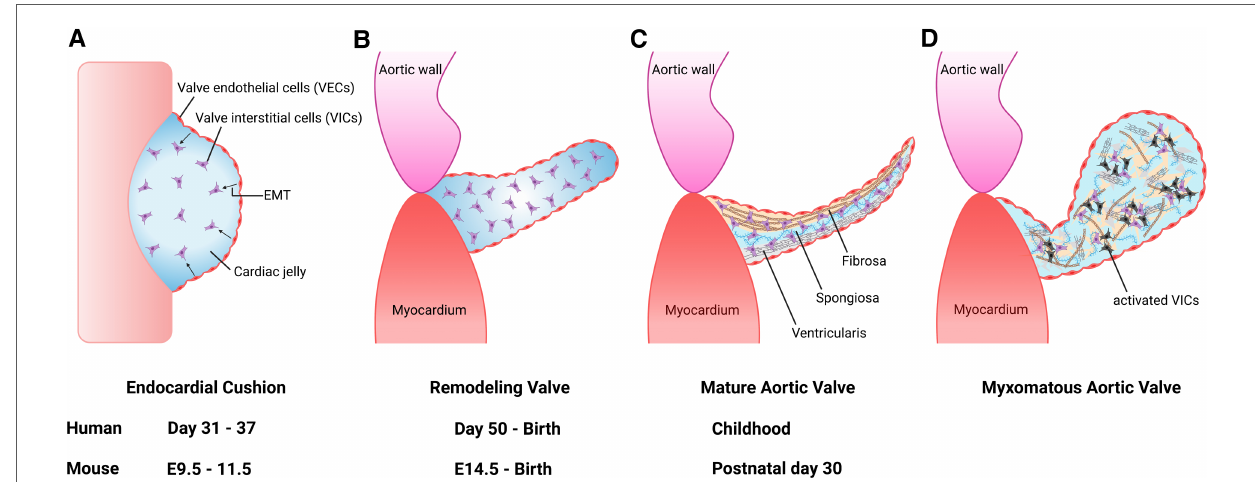
FIGURE 1 Aortic valve development and progression to myxomatous aortic valve. ( A ) Valve development begins with endocardial cushion formation. Valve endothelial cells (VECs) lining the cushion undergo endothelial-to-mesenchymal transformation (EMT) to differentiate into valve interstitial cells (VICs) between 7 and 9 weeks gestation in humans, and embryonic day ( E ) 9.5 and E11.5 in the mouse. ( B ) The out fl ow tract endocardial cushions undergo remodeling into mature valve lea fl et. ( C ) Mature valve layers consist of fi brosa, spongiosa, and ventricularis. ( D ) Myxomatous alterations associated with lea fl et thickening, activated VICs (black cells), disorganized extracellular matrix, diffuse accumulation of proteoglycans and fragmentation of collagen and elastin fi